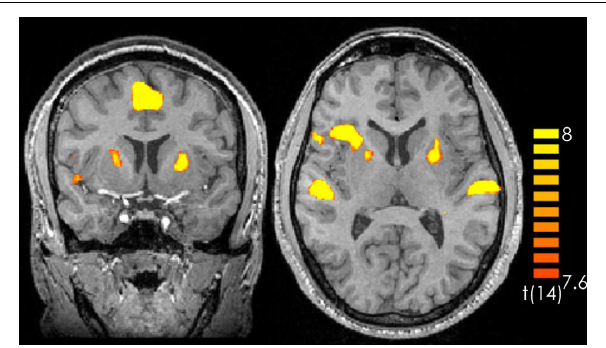
FIGURE 1 | Contrast of music > silence over all participants and all music pieces. The yellow-colored regions represent activation during the music presentation. p < 0 . 05 (Bonferroni corrected).